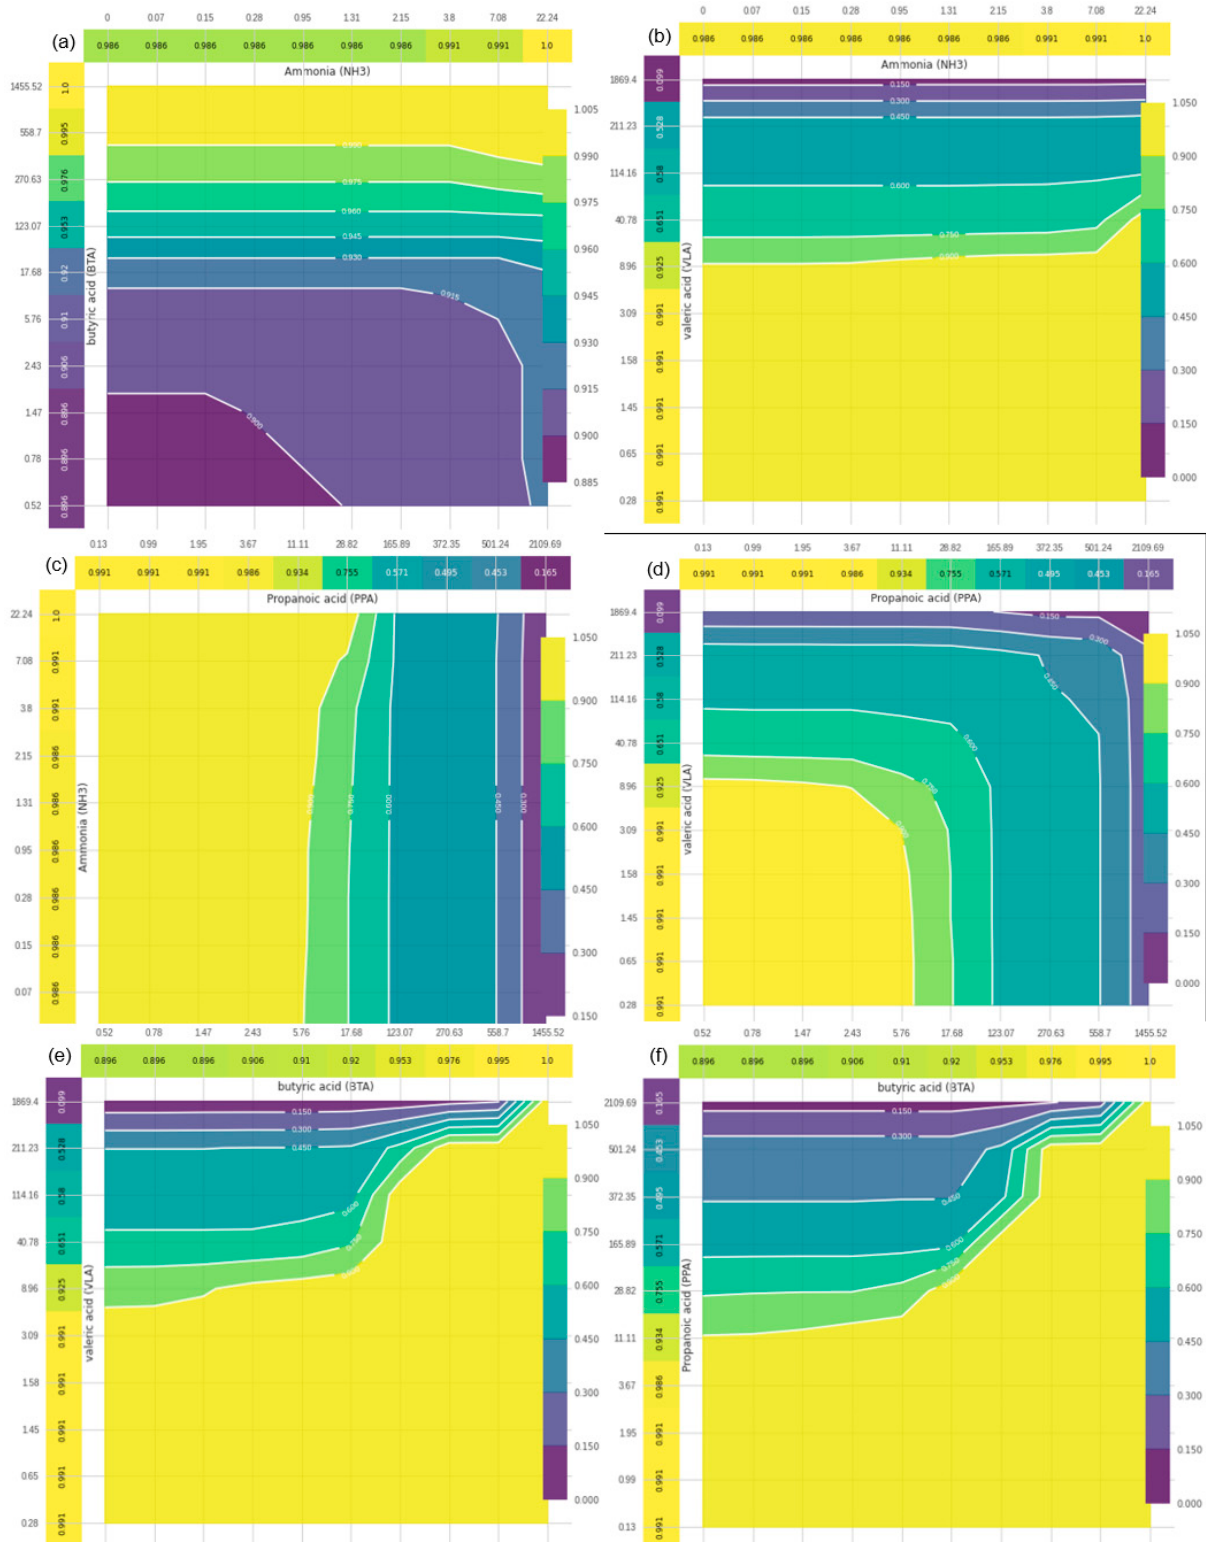
Figure 9. Partial dependence interaction plots for four odor main species (NH3, PPA, BTA, and VLA). ( a ) Interaction plot of NH3 and BTA. ( b ) interaction plot of NH3 and VLA. ( c ) interaction plot of PPA and NH3. ( d ) interaction plot of PPA and VLA. ( e ) interaction plot of BTA and VLA. ( f ) interaction plot of BTA and